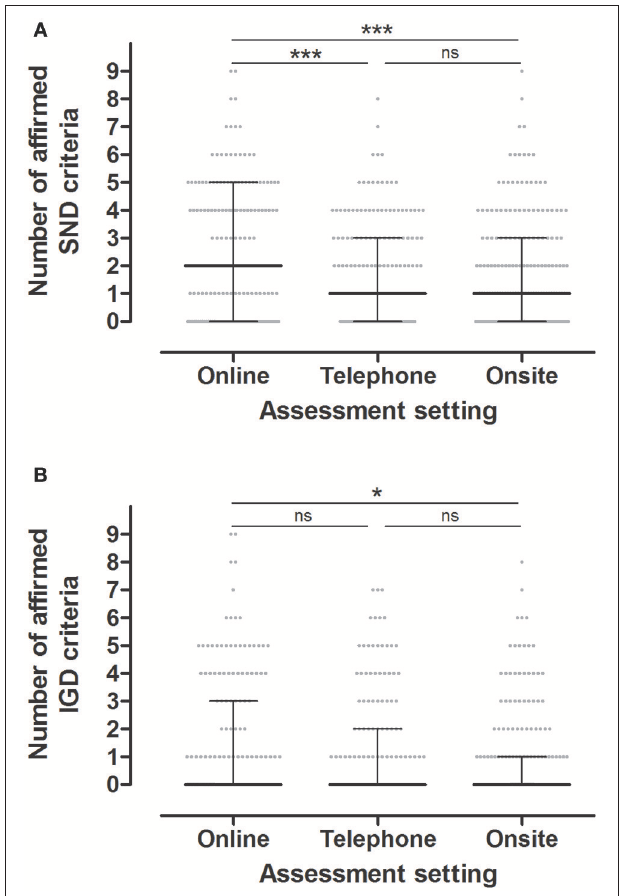
FIGURE 1 | The graphs show median and interquartile range of number of affirmed SND (A) and IGD (B) criteria in different assessment settings. SND social network use disorder, IGD internet gaming disorder. * P < 0.05, *** P < 0.001; ns, not significant.